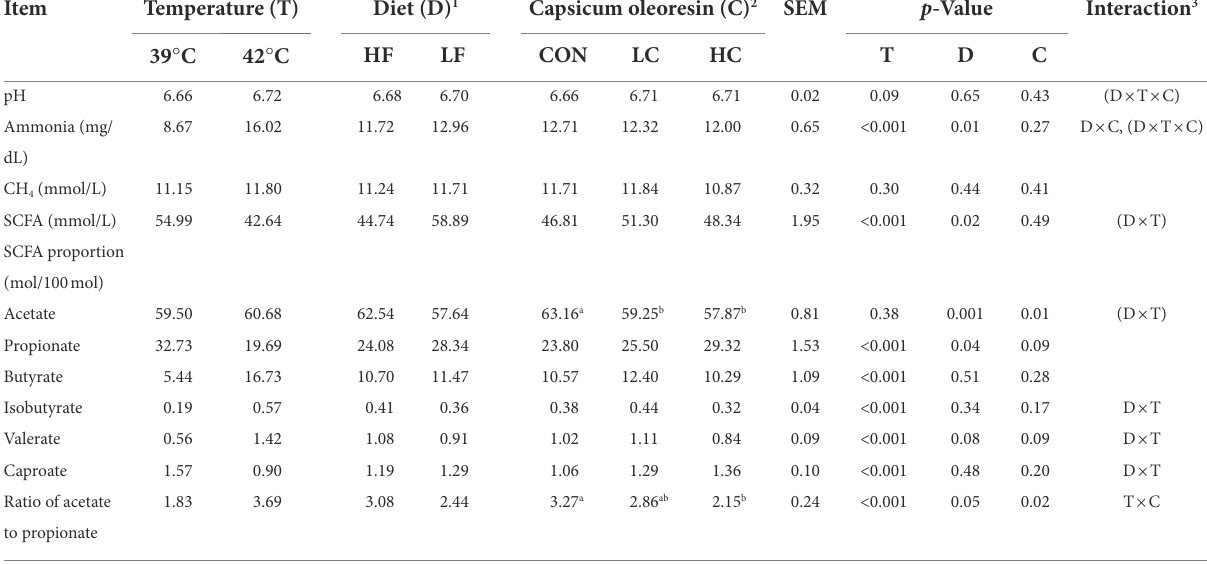
TABLE 3 Fermentation characteristics as affected by temperature, diet, Capsicum oleoresin (CAP) supplementation, and their